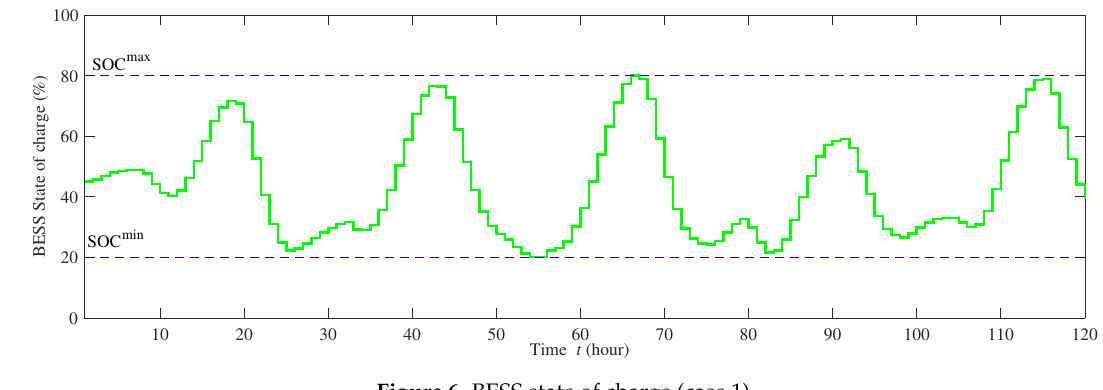
Figure 6. BESS state of charge (case